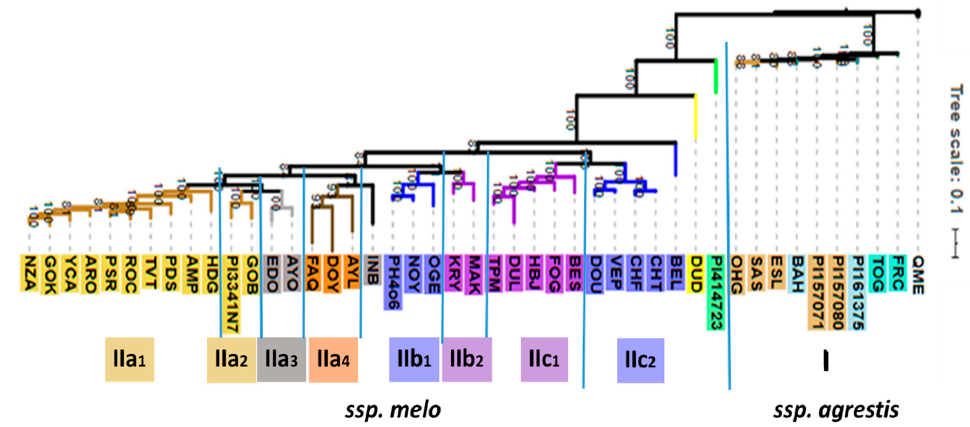
Figure 2. Phylogram representing the phylogenetic relationships of the 44 accessions of C. melo used for GBS analysis in this study. The feral QME serves as outlier. Bootstrap values are based on 100